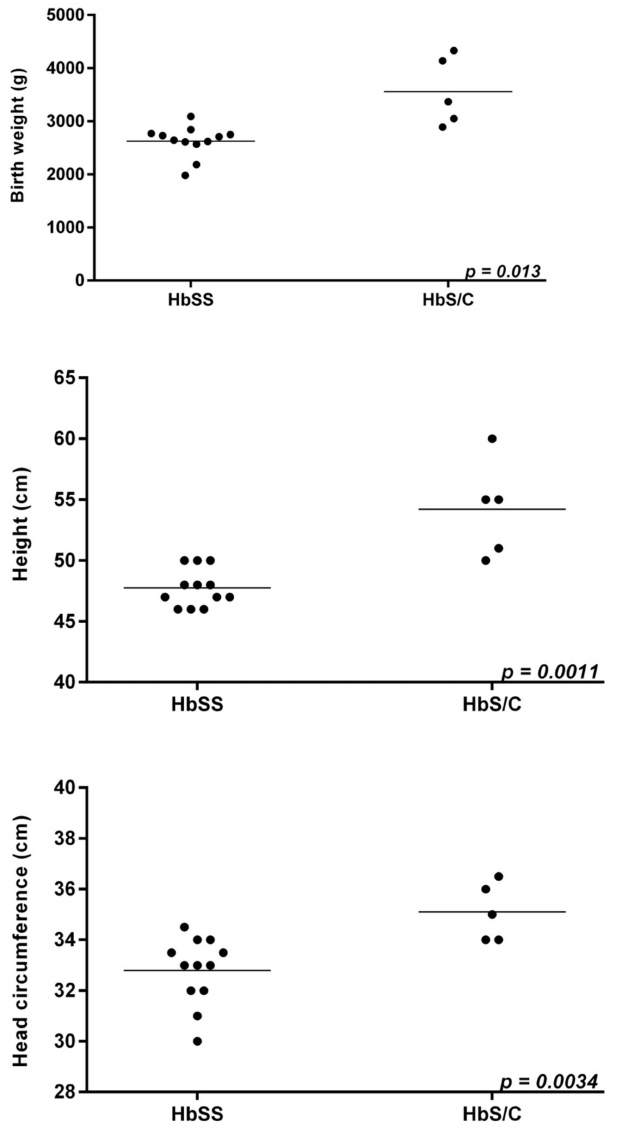
Figure 1. Neonatal status (Birth weight (g), height (cm), and head circumference (cm)) from women with HbSS (N = 12) versus HbS/C disease (N = 5) ± co-inheritance of heterozygous α -thalassemia, excluding preterm